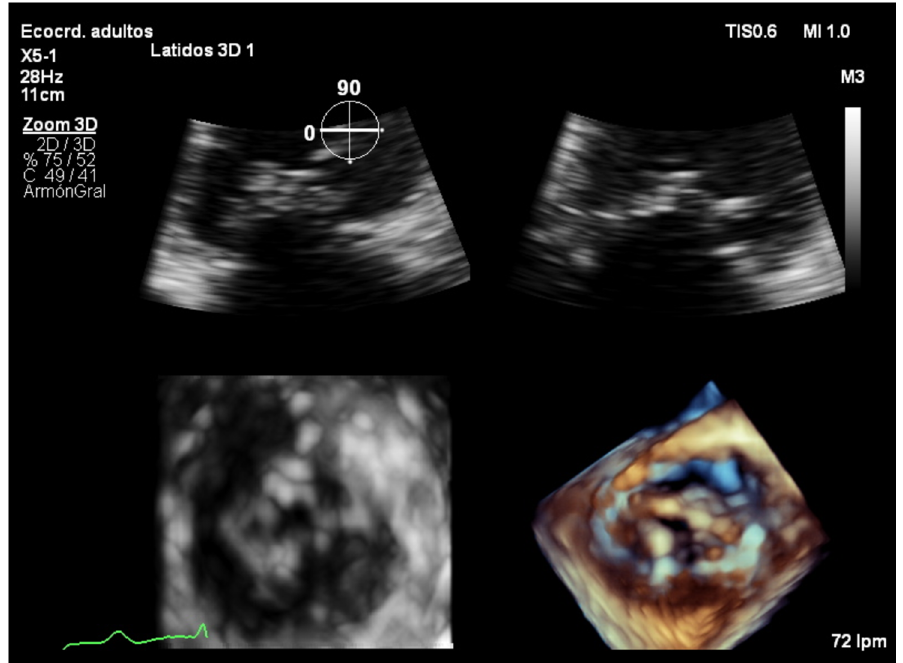
Figure 6. Zoom 3D focused on the mitral valve from the apical four chamber view.